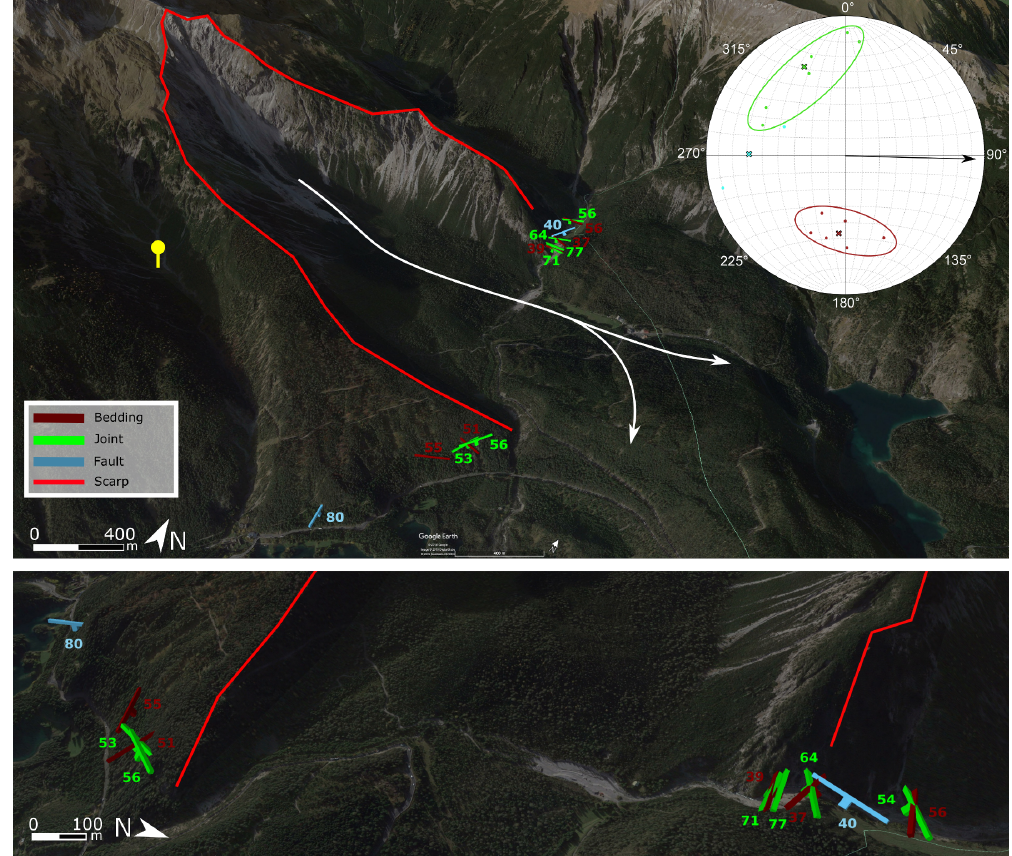
Figure 8. Two Google Earth R (cid:13) views with the strike-dip symbols of the measurement took the Fernpass rock avalanche and a stereonet: the upper image shows a global view the rockslide and the lower image is a zoom on the measurements. The numbers near the strike-dip symbols are the values of the dip and the white arrow displays the direction of the slide. Dots on the stereonet are the poles of the great circles and the black arrow shows the direction of the slide. The yellow icon, on the upper image, has as coordinates of latitude 47 ◦ 21 (cid:48) 8.59 (cid:48)(cid:48) N and of longitude 10 ◦ 48 (cid:48) 2.63 (cid:48)(cid:48)